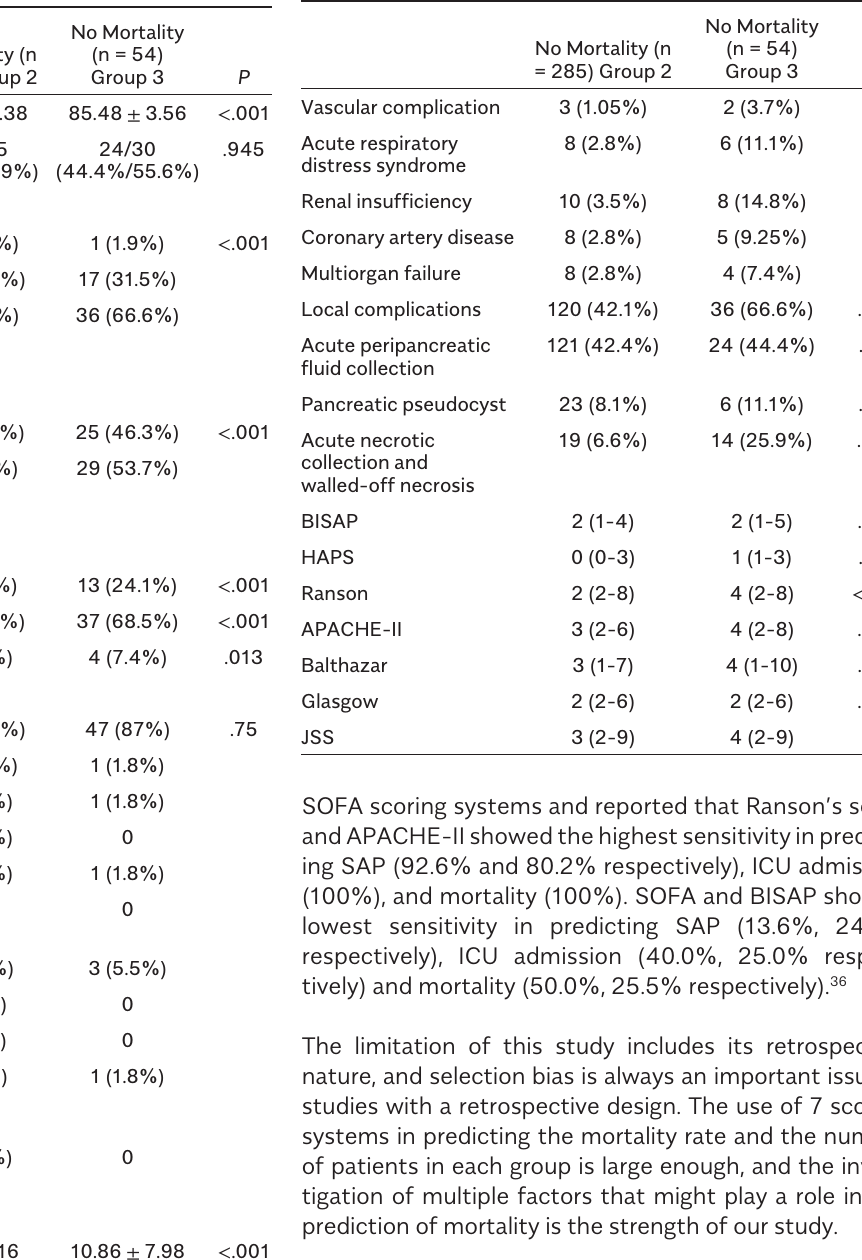
Table 4. Differences Between Alive Patients Aged 65-80 Years and Over 80 Years ( Continued